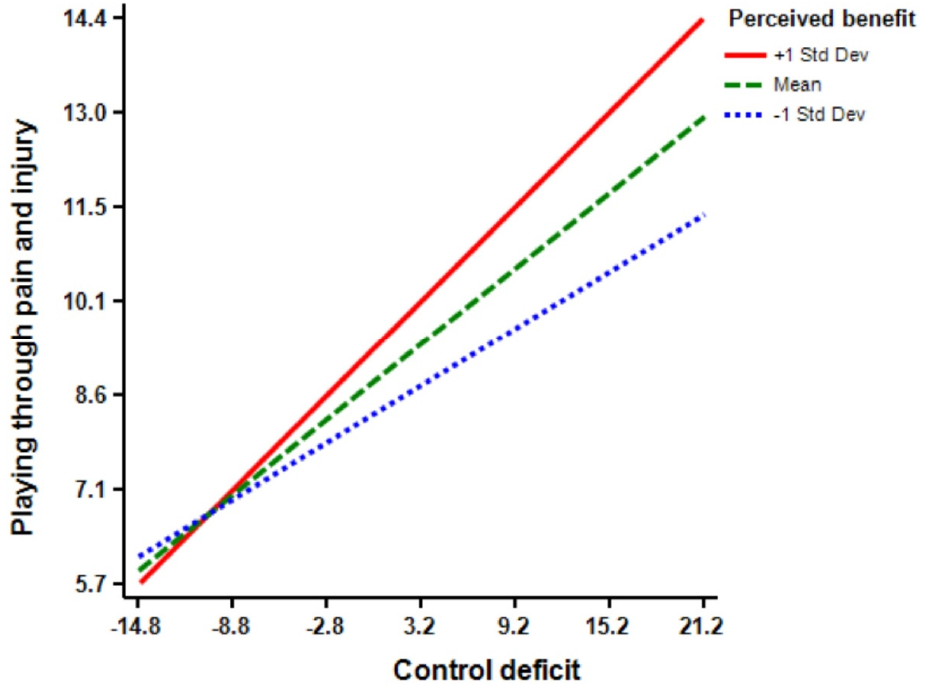
Figure 7. Perceived benefit by control balance deficit interaction. Table 4 exhibits the results for the slope of the regression line test. Briefly, the findings indicate that simple slopes for the association between all moderators and playing through pain and injury for low ( − 1 SD below the mean), moderate (mean), and high (+1 SD above the mean) levels were significant. Table 4. Results for Slope of Regression Line Tests ( n = 410).